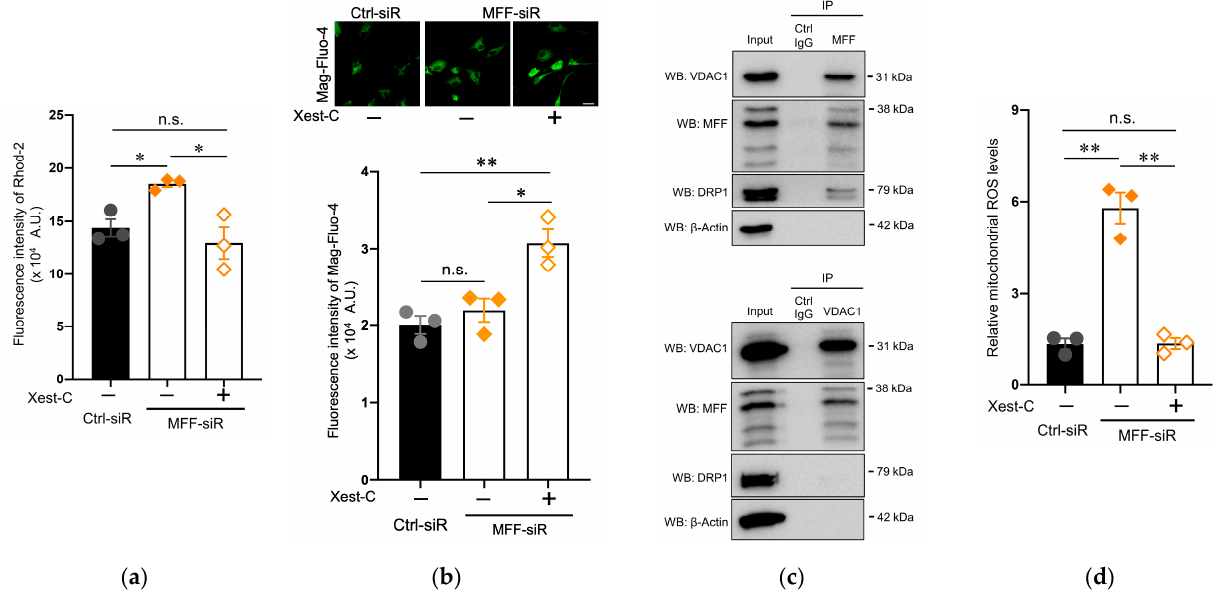
Figure 4. IP3R inhibitor Xest-C suppressed mitochondrial Ca 2+ and ROS accumulation in DNs with MFF insufficiency. Stem cells from human exfoliated deciduous teeth were differentiated into DNs in the absence or presence of Xest-C. ( a ) DNs were stained with Rhod-2 AM. The fluorescence intensity of Rhod-2 AM was measured using a plate reader. The mean ± SEM was taken from three independent experiments. n.s., not significant, * p < 0.05. ( b ) DNs stained with Mag-Fluo-4 AM were observed by confocal microscopy. Scale bar = 25 μ m. The fluorescence intensity of Mag-Fluo-4 AM was measured using a plate reader. The mean ± SEM was taken from three independent experiments. n.s., not significant, * p < 0.05, ** p < 0.01. ( c ) IP was performed using an anti-MFF (upper panel) and anti-VDAC1 (lower panel) antibodies in untreated DNs. Immunoprecipitants were detected by Western blotting (WB) using the indicated antibodies. ( d ) Mitochondrial ROS levels were measured using flow cytometry. The mean ± SEM was taken from three independent experiments. n.s., not significant. ** p < 0.01.